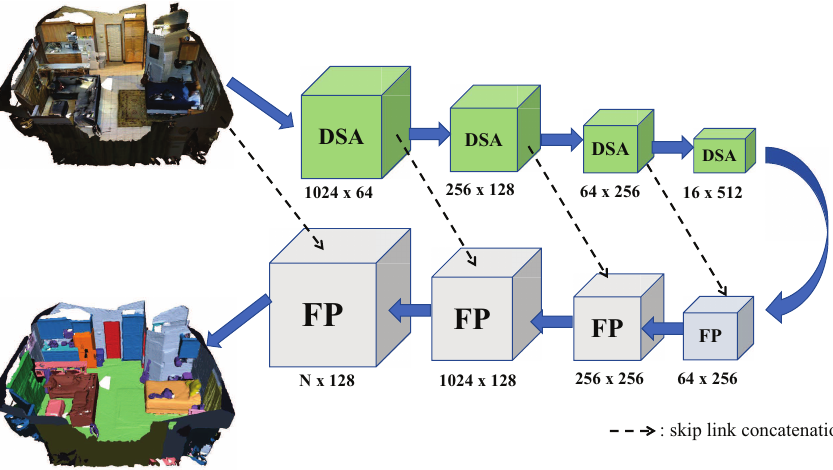
Figure 4. Illustration of the proposed end-to-end network